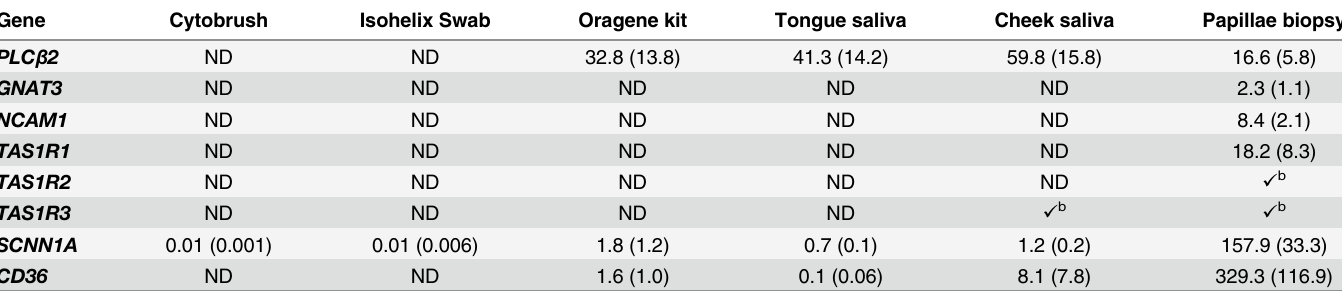
Table 3. Quantitative real-time PCR analysis of taste markers and receptors using the different collection techniques a